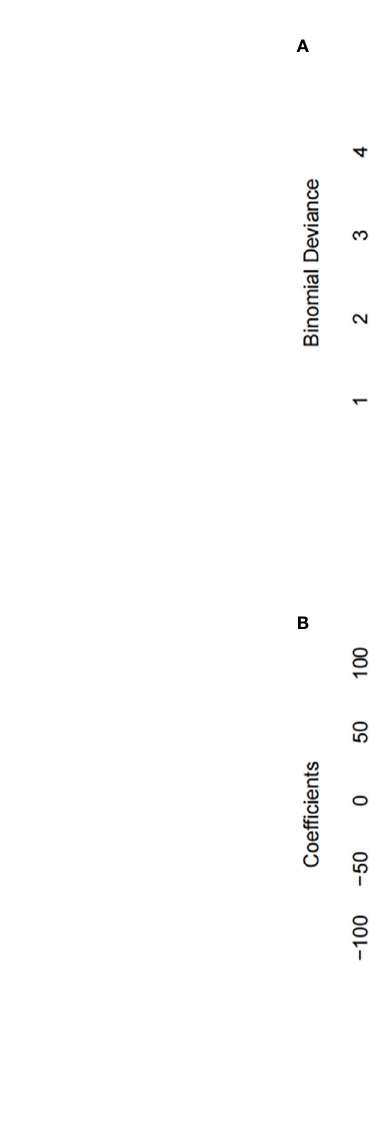
FIGURE 3 Feature selection proceeded using mRMR and LASSO. (A) LASSO method was used to con fi rm the optimal adjustment parameter l , and the vertical line was drawn according to the value selected by 10-fold cross-validation. (B) the trend lines of model coef fi cients drawn for 829 imaging